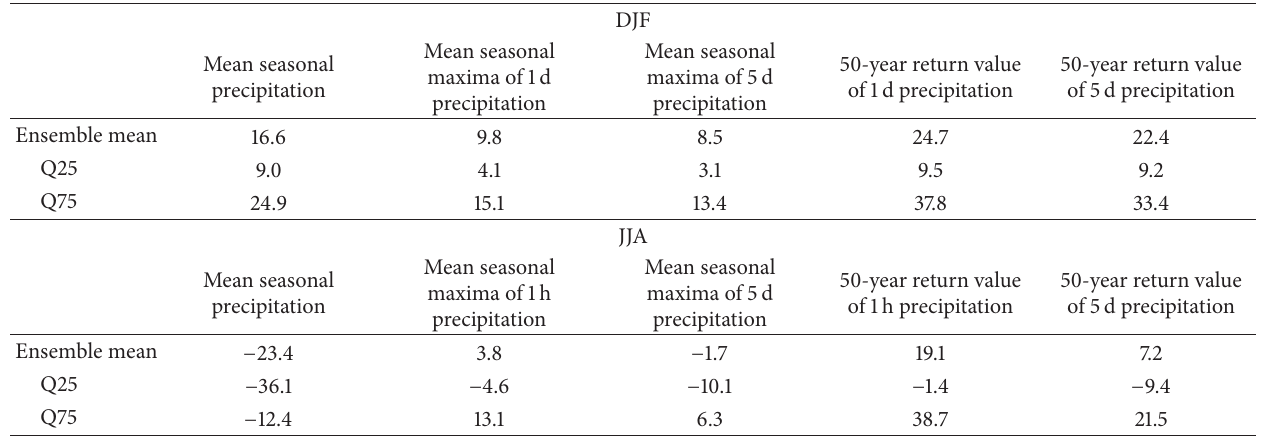
Table 4: Ensemble mean and ensemble quantiles (25% and 75%; Q25 and Q75, resp.) of relative changes (in %) in mean seasonal precipitation totals, mean seasonal maxima, and 50-year return values of 1-hour/1-day and 5-day precipitation amounts in the Carpathian Basin between 2070–2099 and